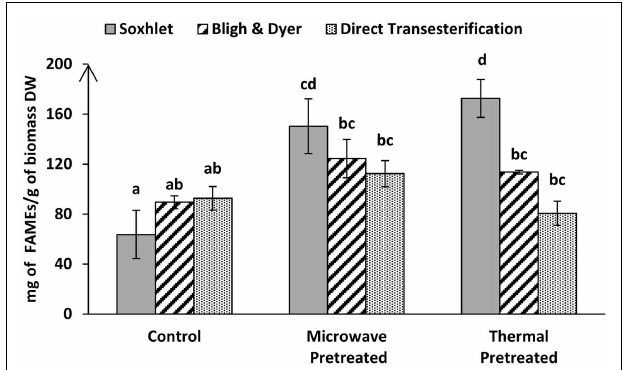
FIGURE 5 |Total FAME recoveries obtained by GC-MS from lyophilized Tetraselmis sp. M8 biomass via indirect transesterification through Bligh & Dyer or Soxhlet and direct transesterification using different pre-treatment systems . Different letters represent significant statistical differences ( P < 0.05).